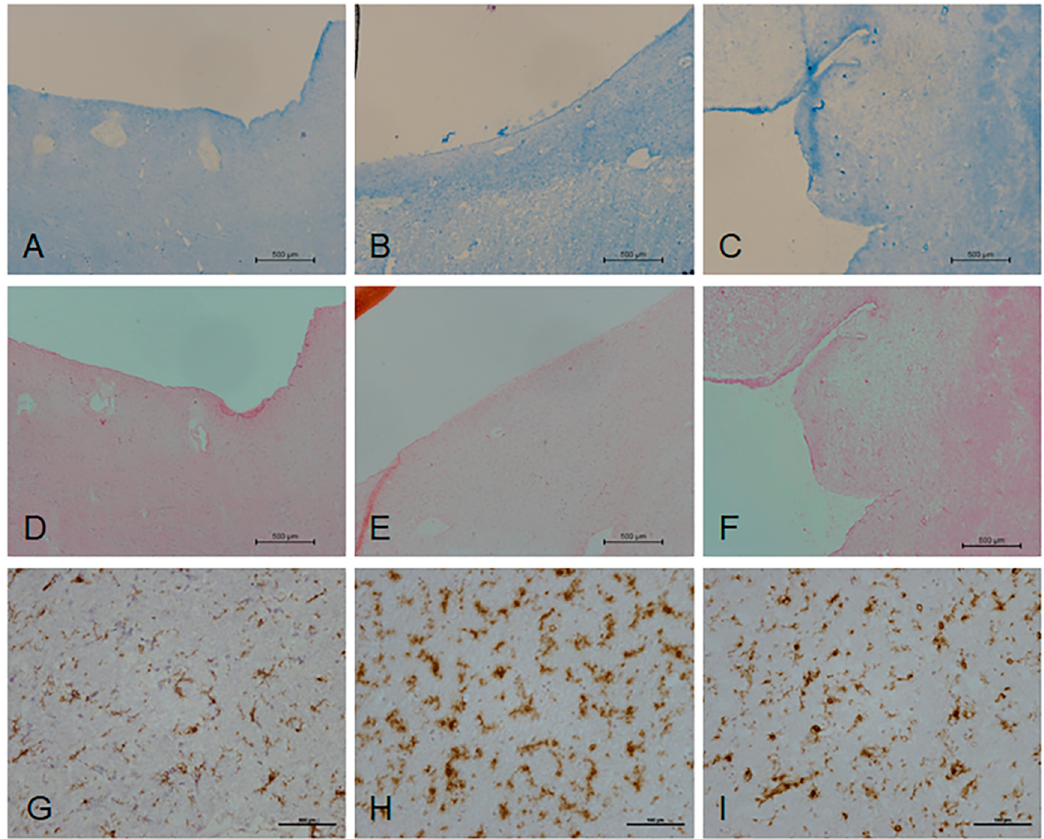
Figure 1. Histological characterisation of periventricular white matter. Luxol fast blue (LFB) ( A , B ) and H&E staining ( D , E ) of radiologically normal appearing white matter demonstrated a regular pattern of myelin staining across the periventricular region. In contrast, LFB ( C ) and H&E staining ( F ) of radiologically identified lesional cases displayed a band of periventricular demyelination. MHC-II immunostaining of radiologically normal appearing white matter identified cases with minimal MHC-II + microglia (( G ), control) but also cases with high levels of MHC-II immunoreactivity (( H ), “pre-lesional”). Radiologically identified periventricular lesions (PVL) contained high levels of MHC-II + microglia ( I ). Scale bar represents 500 µm in ( A – F ) and 100 µm in ( G – I ).